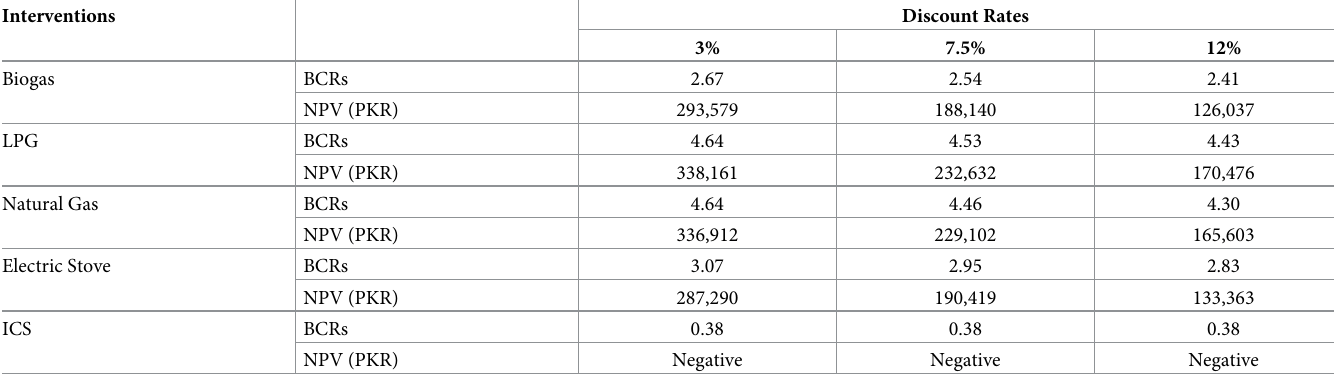
Table 4. BCRs and NPV for all